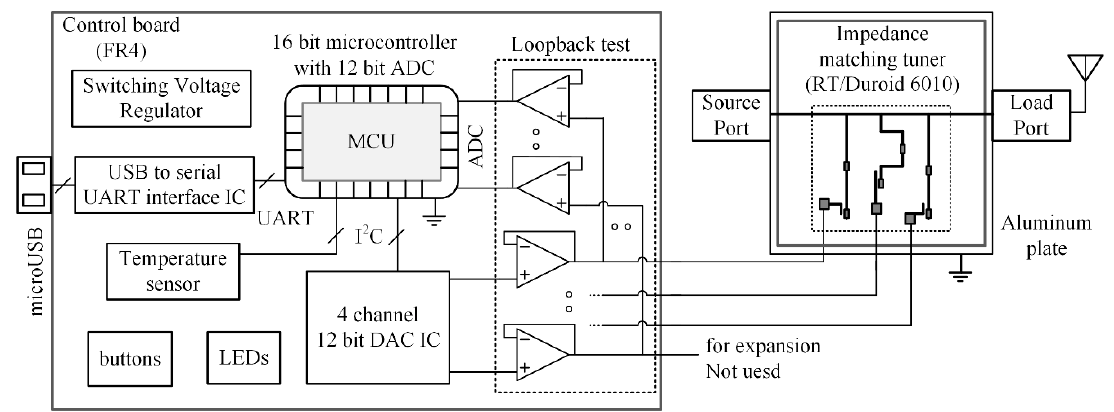
Figure 2. A functional block diagram of the adaptive broadband impedance matching system (AIMS) implementation in this paper.